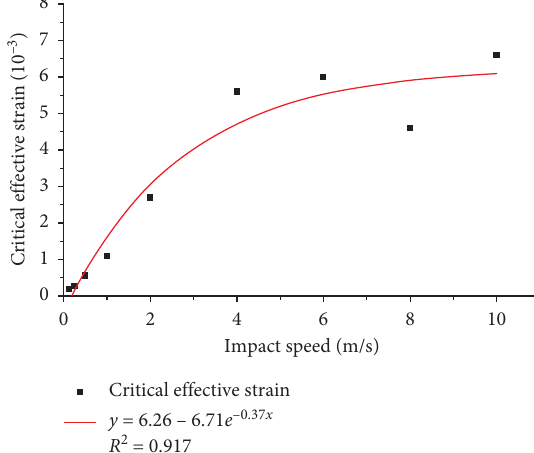
Figure 5: Fitting curve of the speed and critical effective strain.